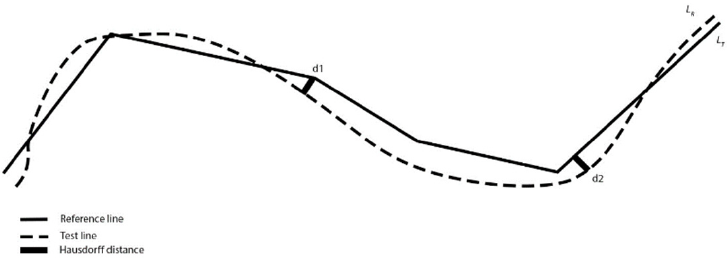
Figure 7. Hausdorff distance survey. Adapted with permission from Santos et al.